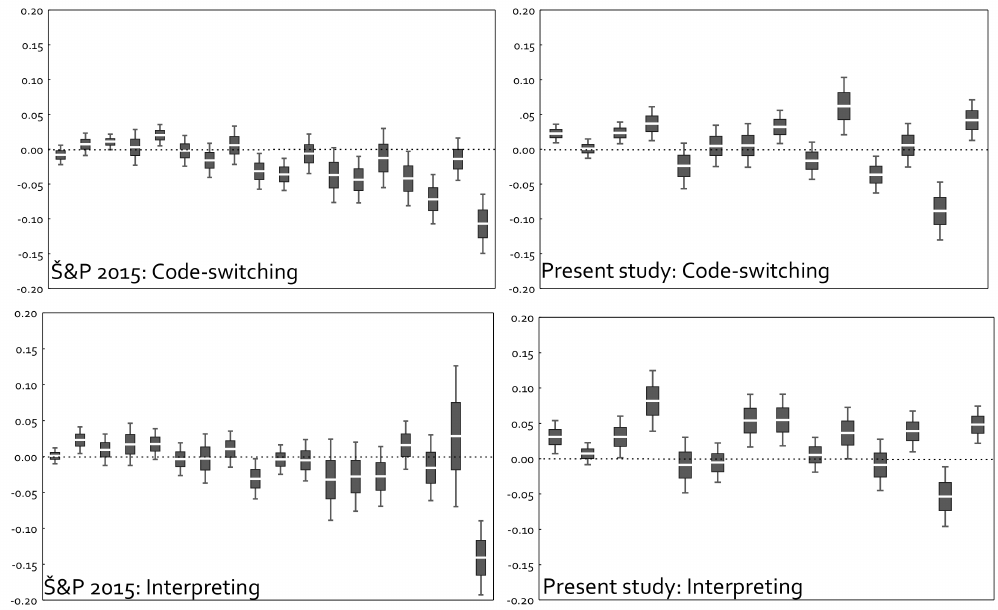
Figure 2. Difference from normalized VOT in the English-only condition: individual speaker’s means, confidence intervals, and standard errors. Within each plot, the speakers are arranged from those with the lowest ( left ) to those with the highest ( right ) mean normalized VOT. Data from Š&P 2015 and the present